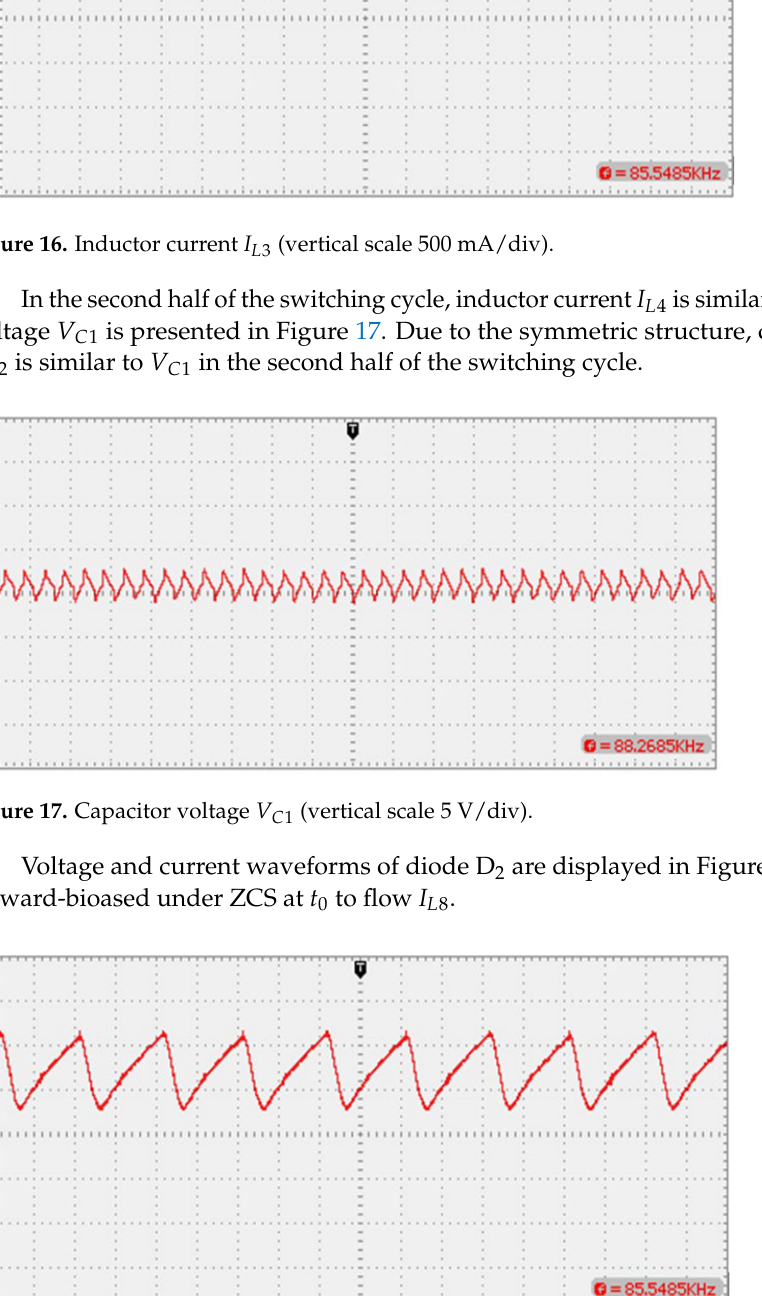
Figure 18. Voltage ( top ) and current ( bottom ) waveforms of diode D 2 (vertical scale 100 V/div or 20 A/div).